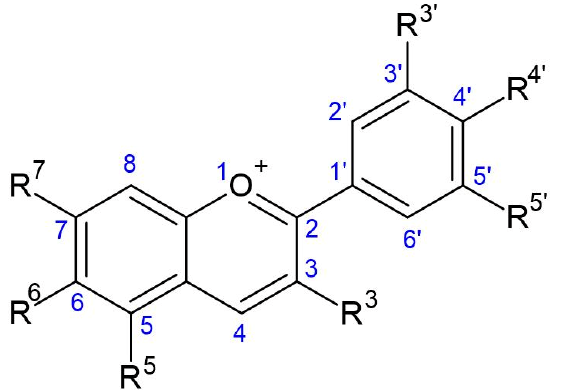
Figure 2. Fundamental structure of anthocyanin. (Drawn using the tool ACD/ChemSketch, version 2021.2.1, Advanced Chemistry Development, Inc., Toronto, ON, Canada)